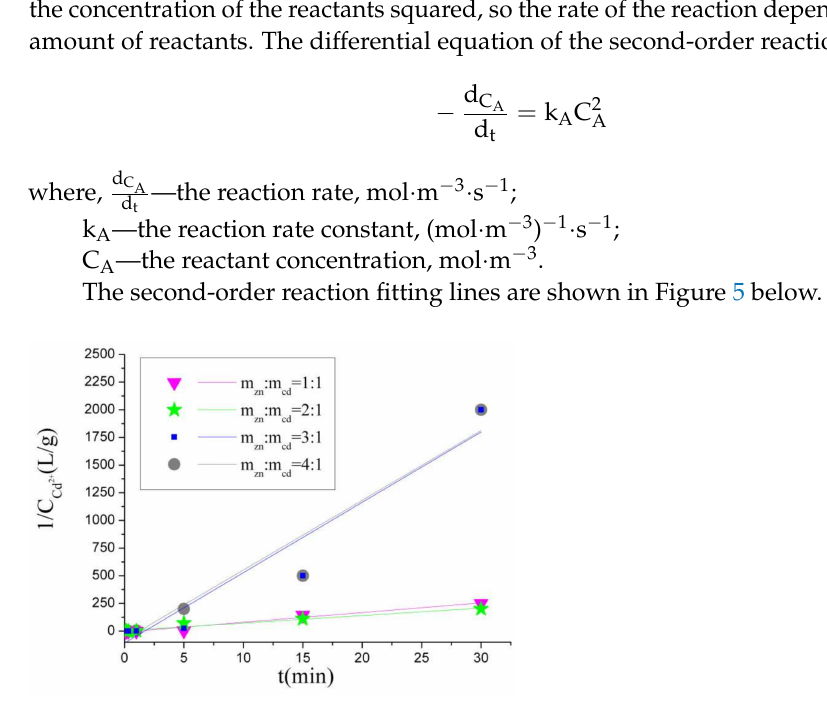
Figure 5. Second-order reaction fitting lines under different zinc powder dosages.